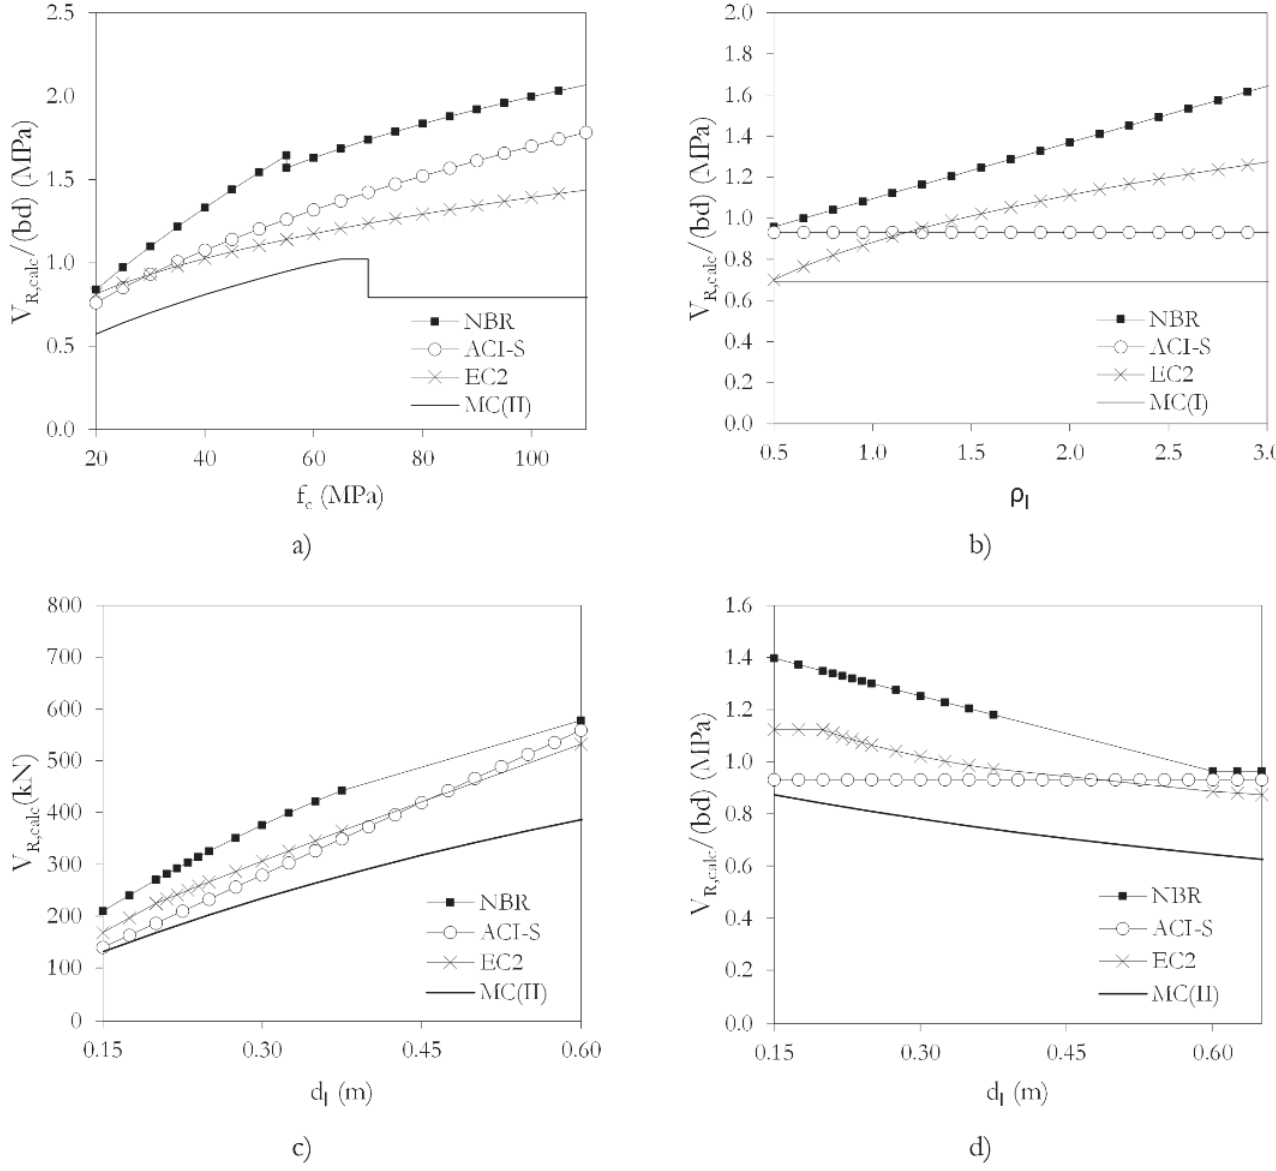
Effect on shear force strength (according to the one-way approach to slabs) of parameters such as: a) Concrete compressive strength, b) ratio of flexural reinforcement and c) and d) effective depth of the elements (scale